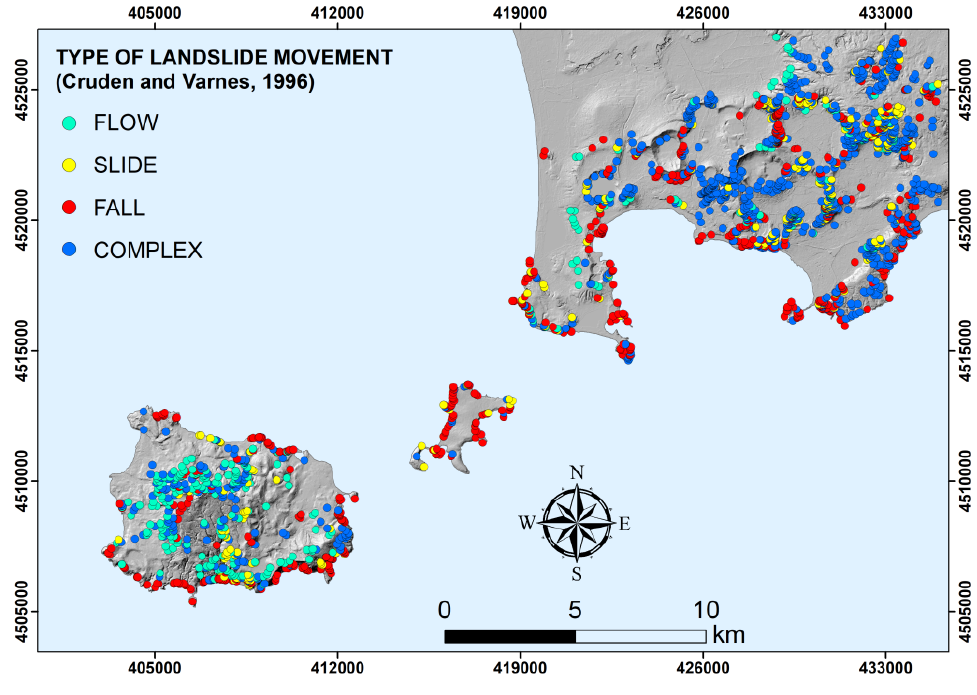
Figure 3. Map of the cataloged landslides, classified according to the type of movement (coordinates in EPSG 32633).